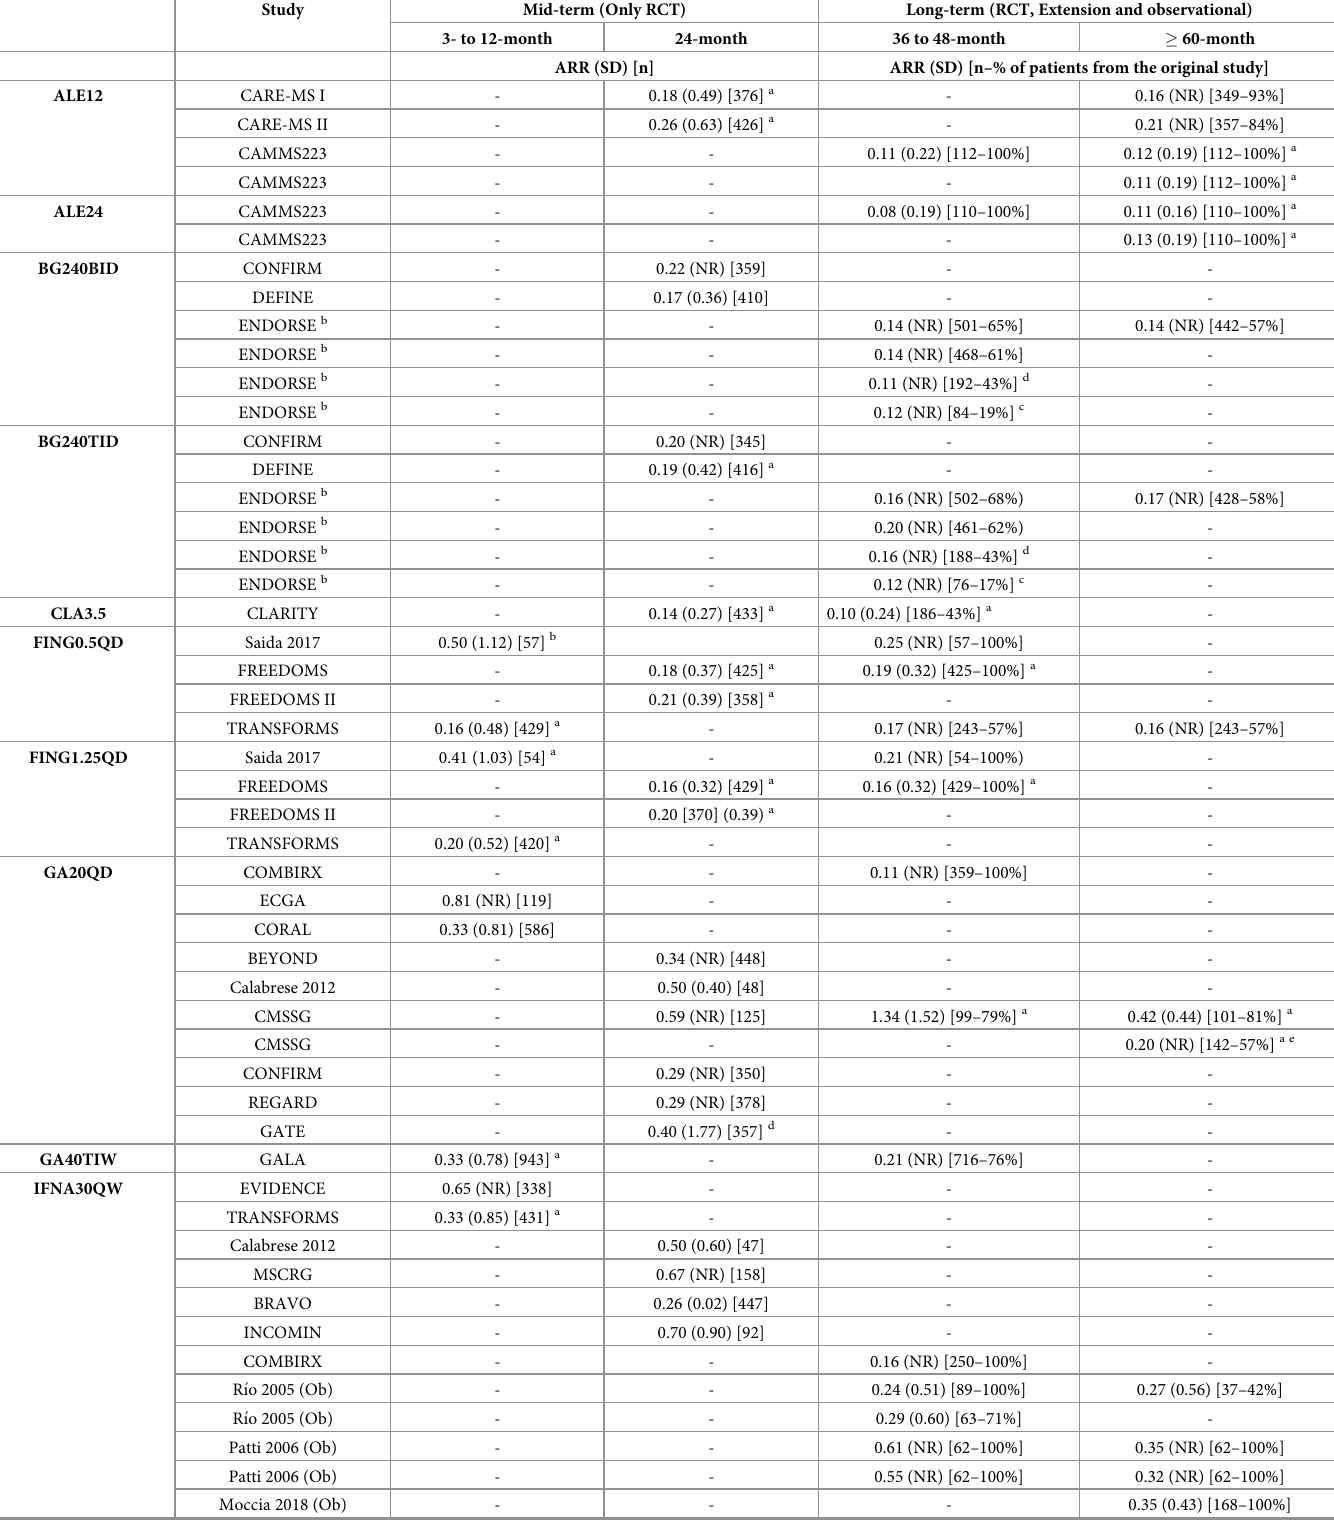
Table 2. Comparison between mid- and long-term annualised relapse